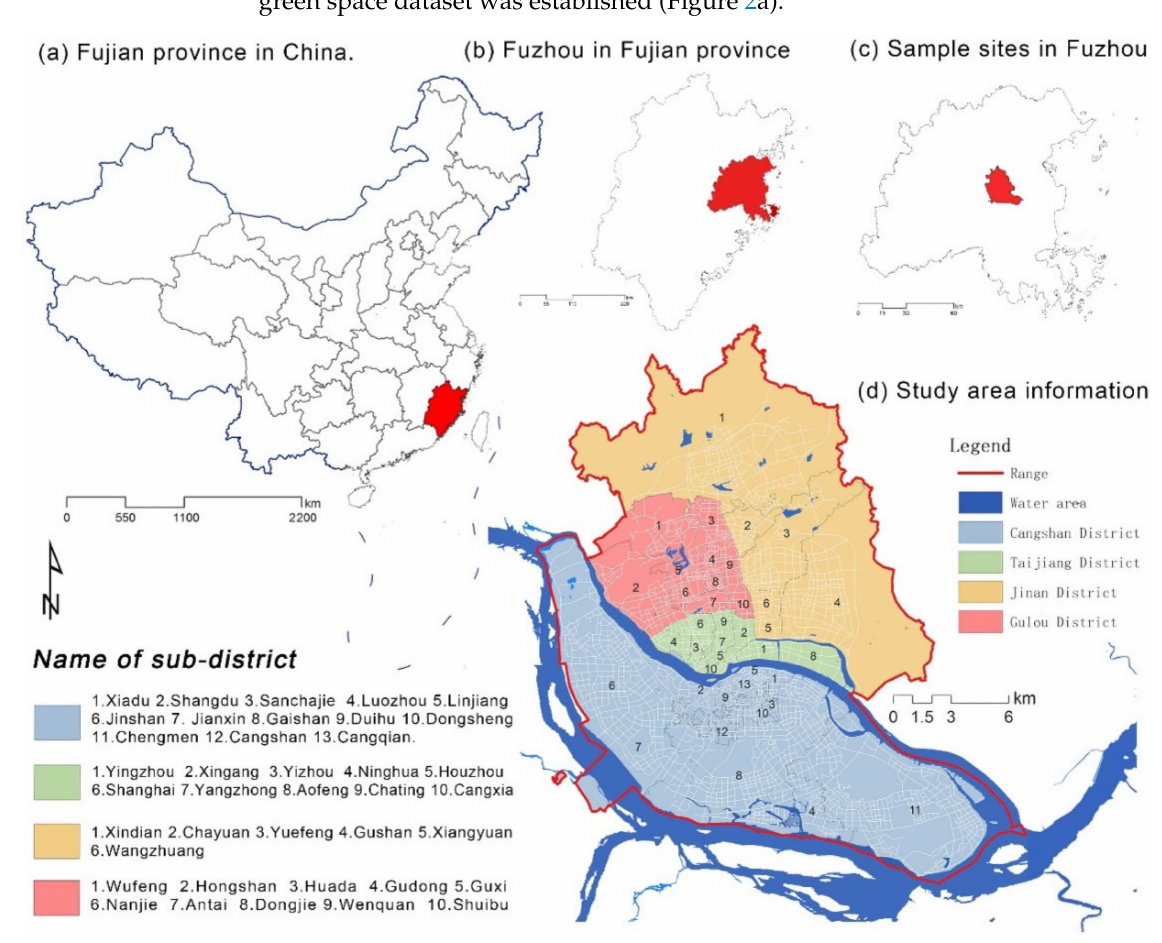
Figure 1. Location and information of study area. Table 1. Classified statistics of